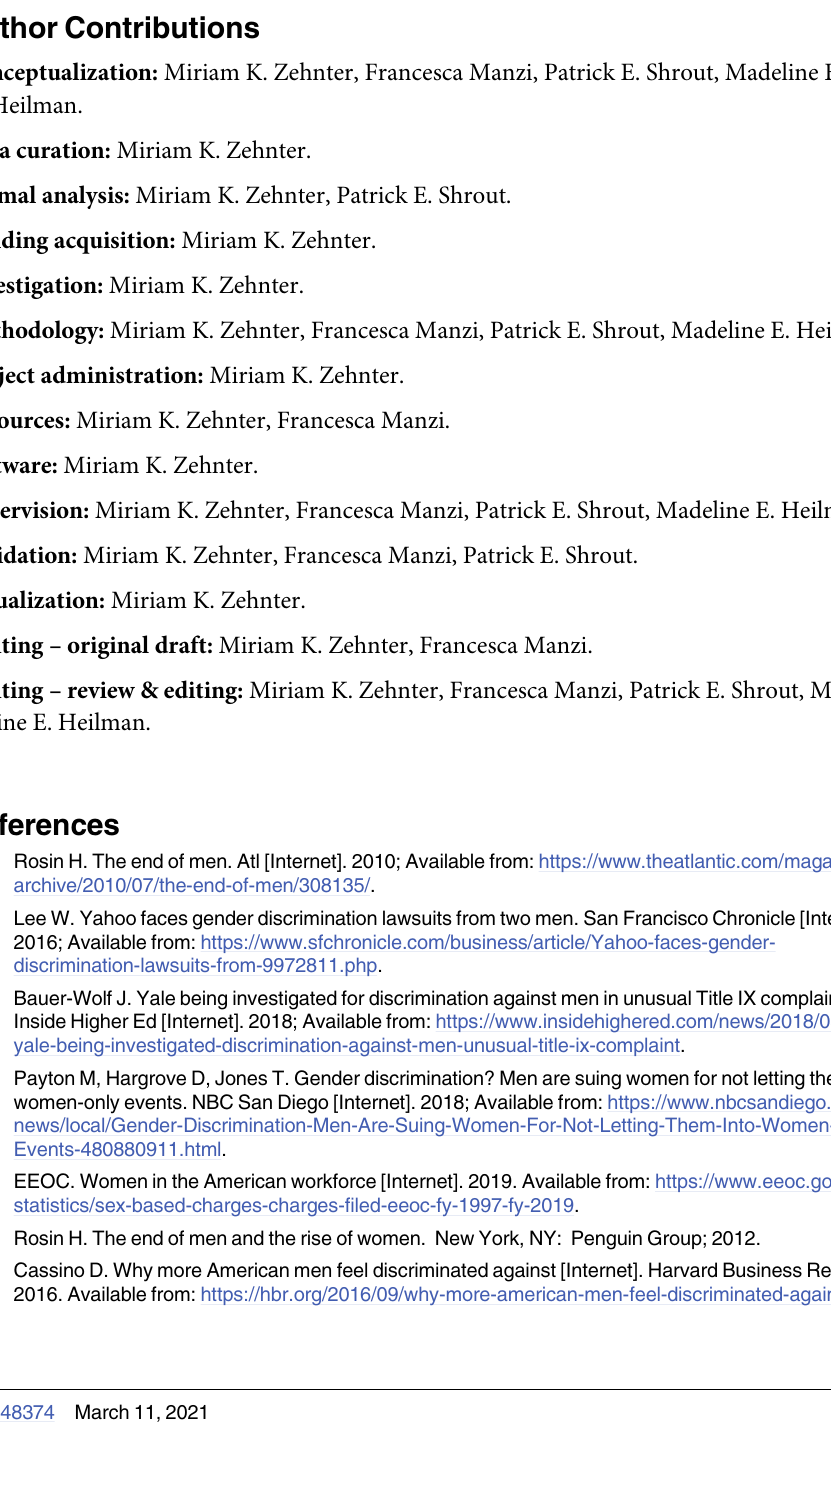
S1 Table. Standardized component and factor loadings of all items by study. S2 Table A Study material for the pilot study B Study material for Study 1 C Study mate- rial for Study